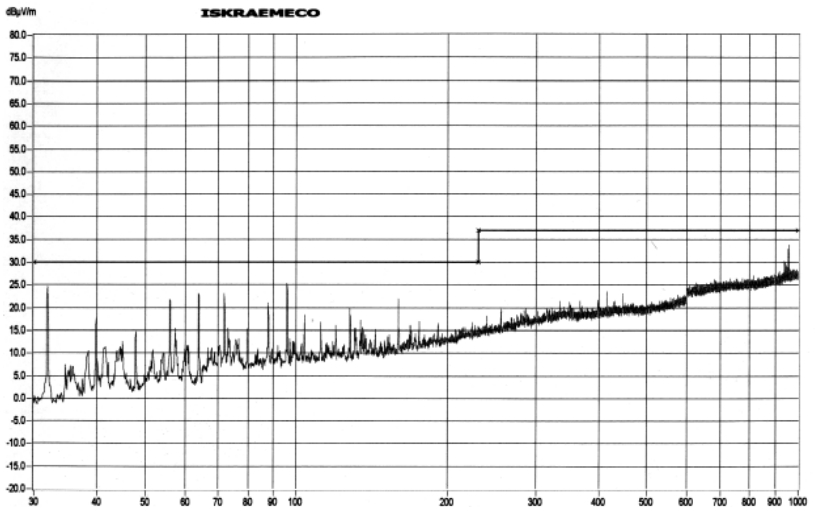
Figure 8. Radiated emission (new